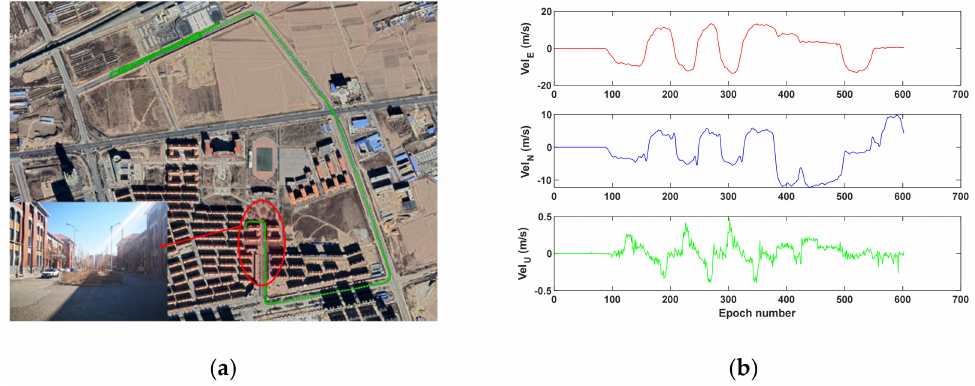
Figure 2. Vehicle’s trajectory ( a ) and reference velocity ( b ); the red circle marks the observation condition with surrounded buildings and